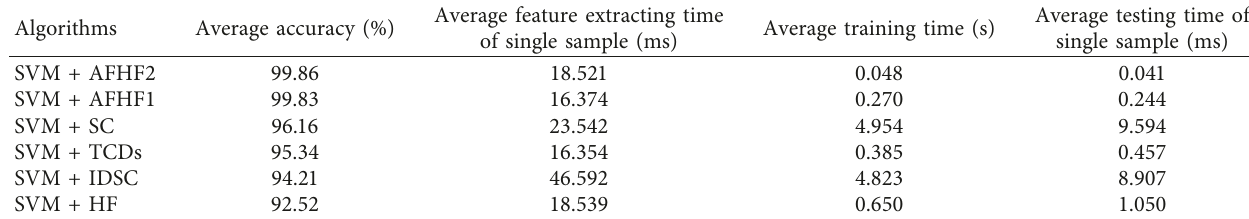
Table 5: Experimental results on actual measured shaft orbit dataset by SVM.